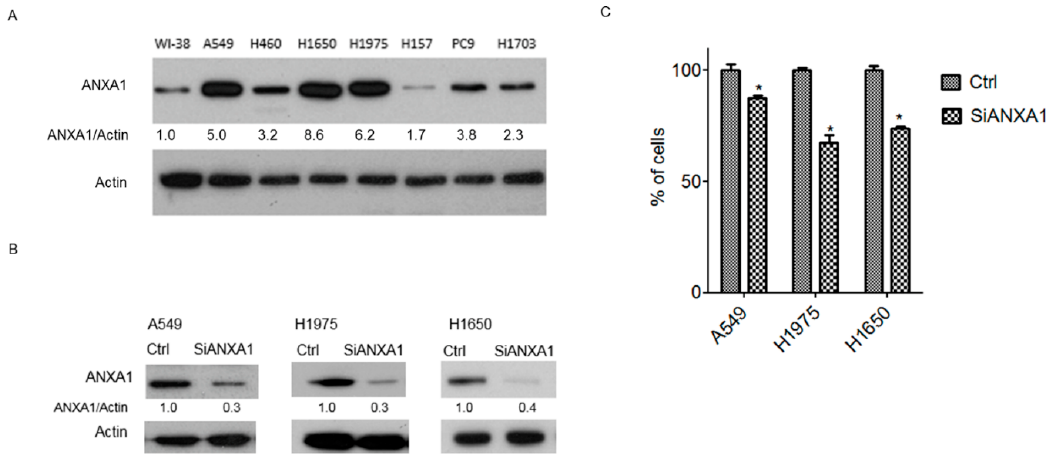
Figure 1. ( A ) Western blot analysis of ANXA1 in lung cancer cells. Internal control: actin. WI-38: human lung